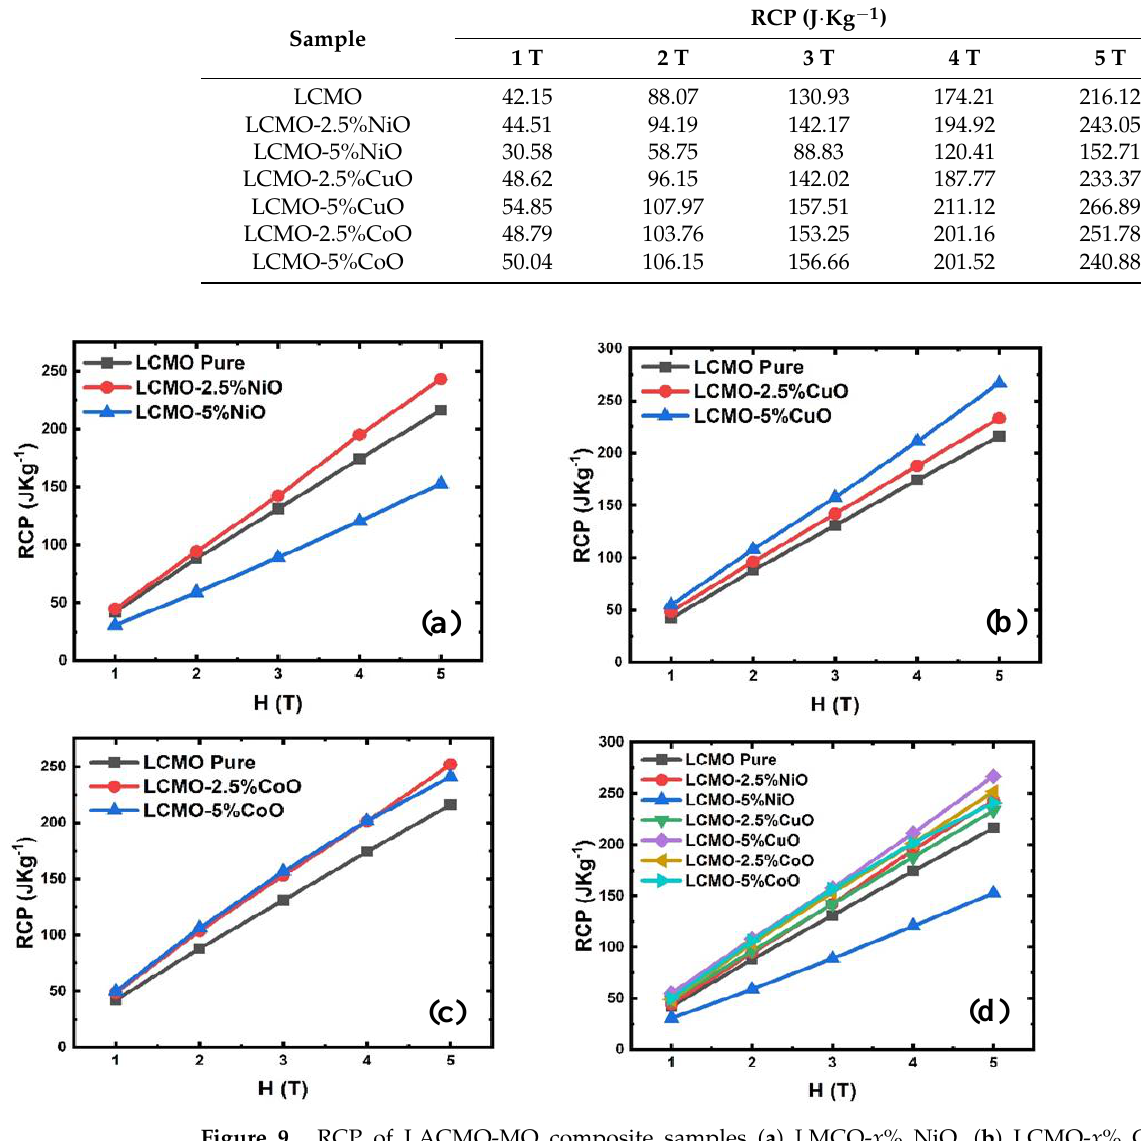
Figure 9. RCP of LACMO-MO composite samples ( a ) LMCO- x % NiO, ( b ) LCMO- x % CuO, ( c ) LCMO- x %CoO, and ( d ) LCMO- x % MO.